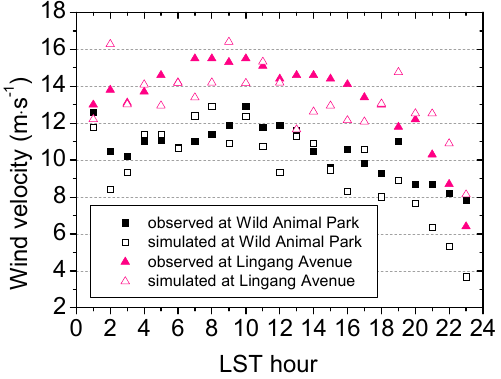
Figure 12. Observed and simulated 10 min average wind velocities at Wild Animal Park and Lingang Avenue metro stations (Figure 1) on LST 11 July 2015 during Typhoon Chan-hom landfall. Table 2. Wind risk scale ( R , Equation (13) for rail transport and the minimum wind velocity at vehicle center height associated with each